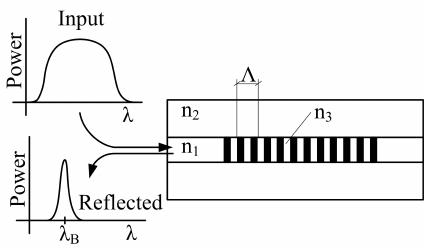
Figure 2. Blog diagram of the FBG